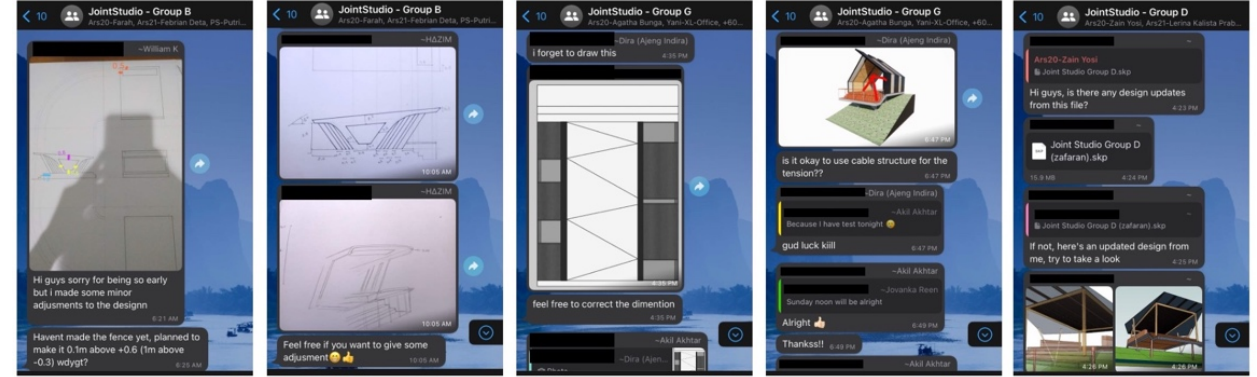
Figure 4. Photos of collaborative learning process outside the workshop.